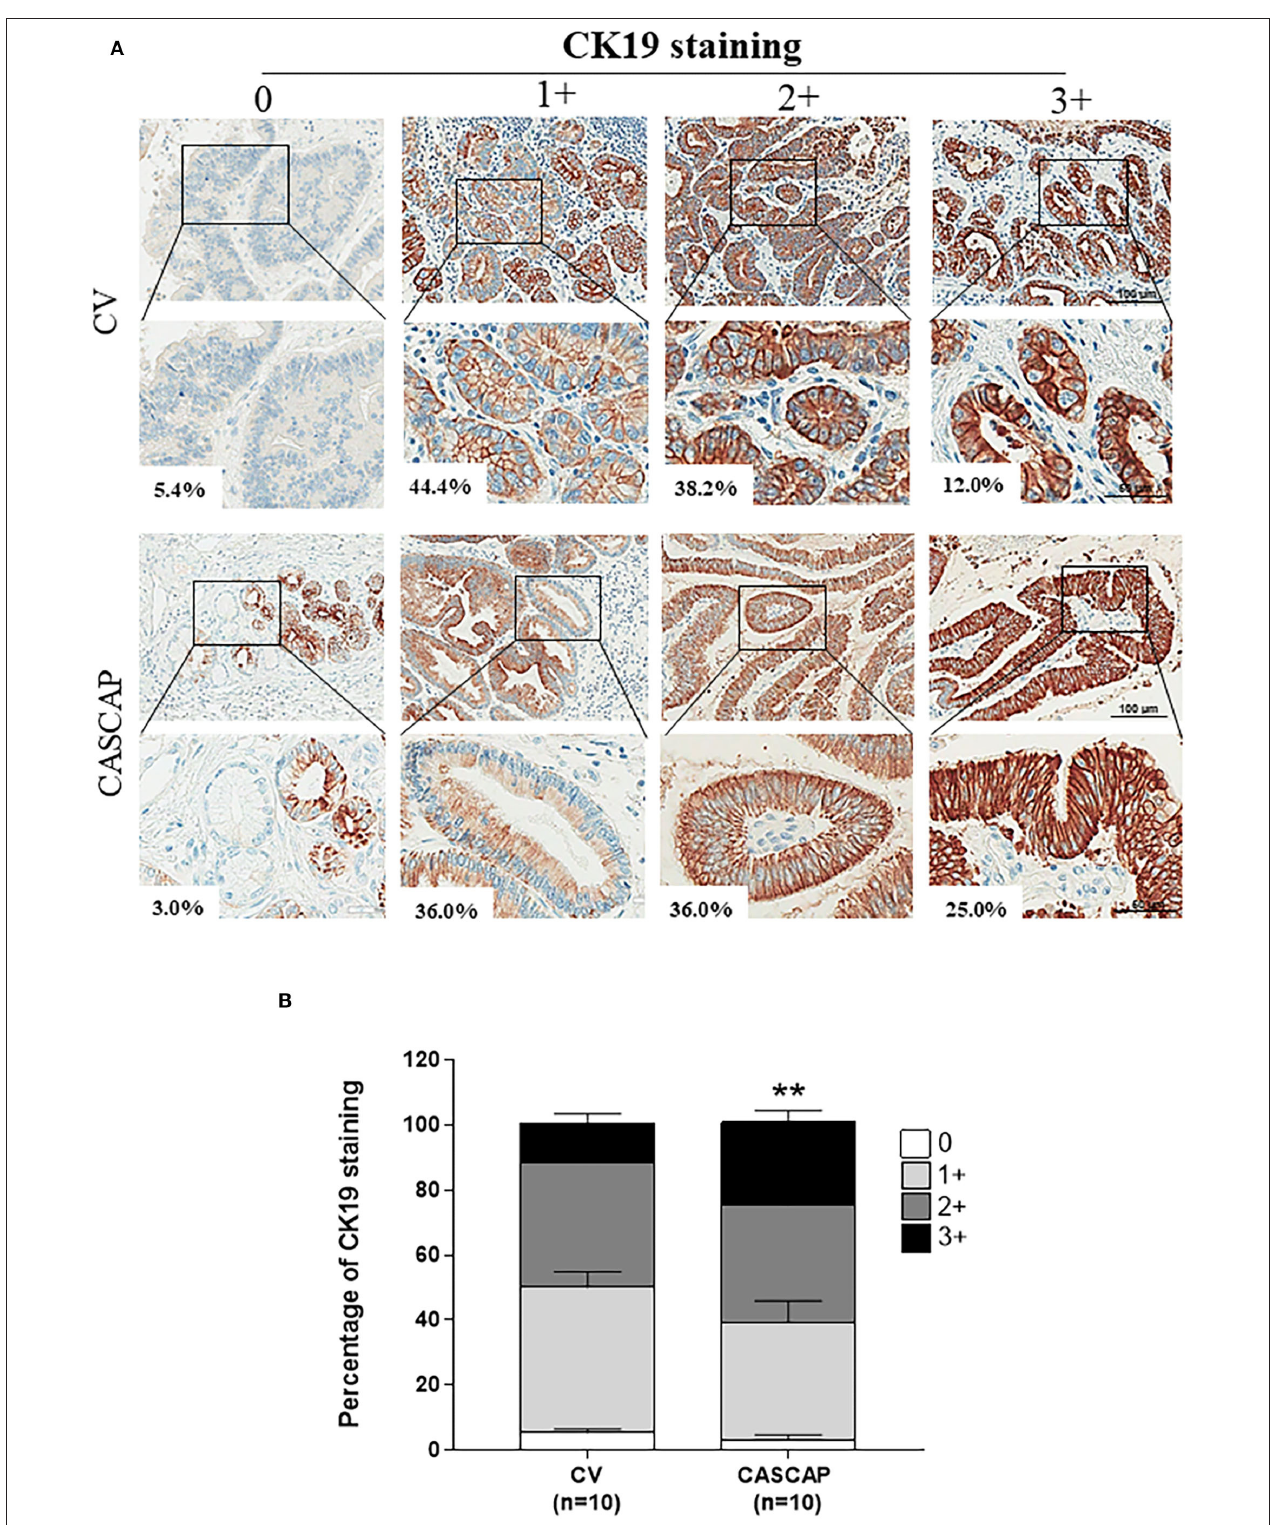
FIGURE 3 | Immunohistochemical assessment of cytoplasmic CK19 intensities in CCA tissue sections from 0 to + 3 (A) . Percentages of each cytokeratin 19 (CK19) intensities between conventional method (CV) and new methods (CASCAP) (B). Data are shown as mean ± SEM, ** p < 0.01.